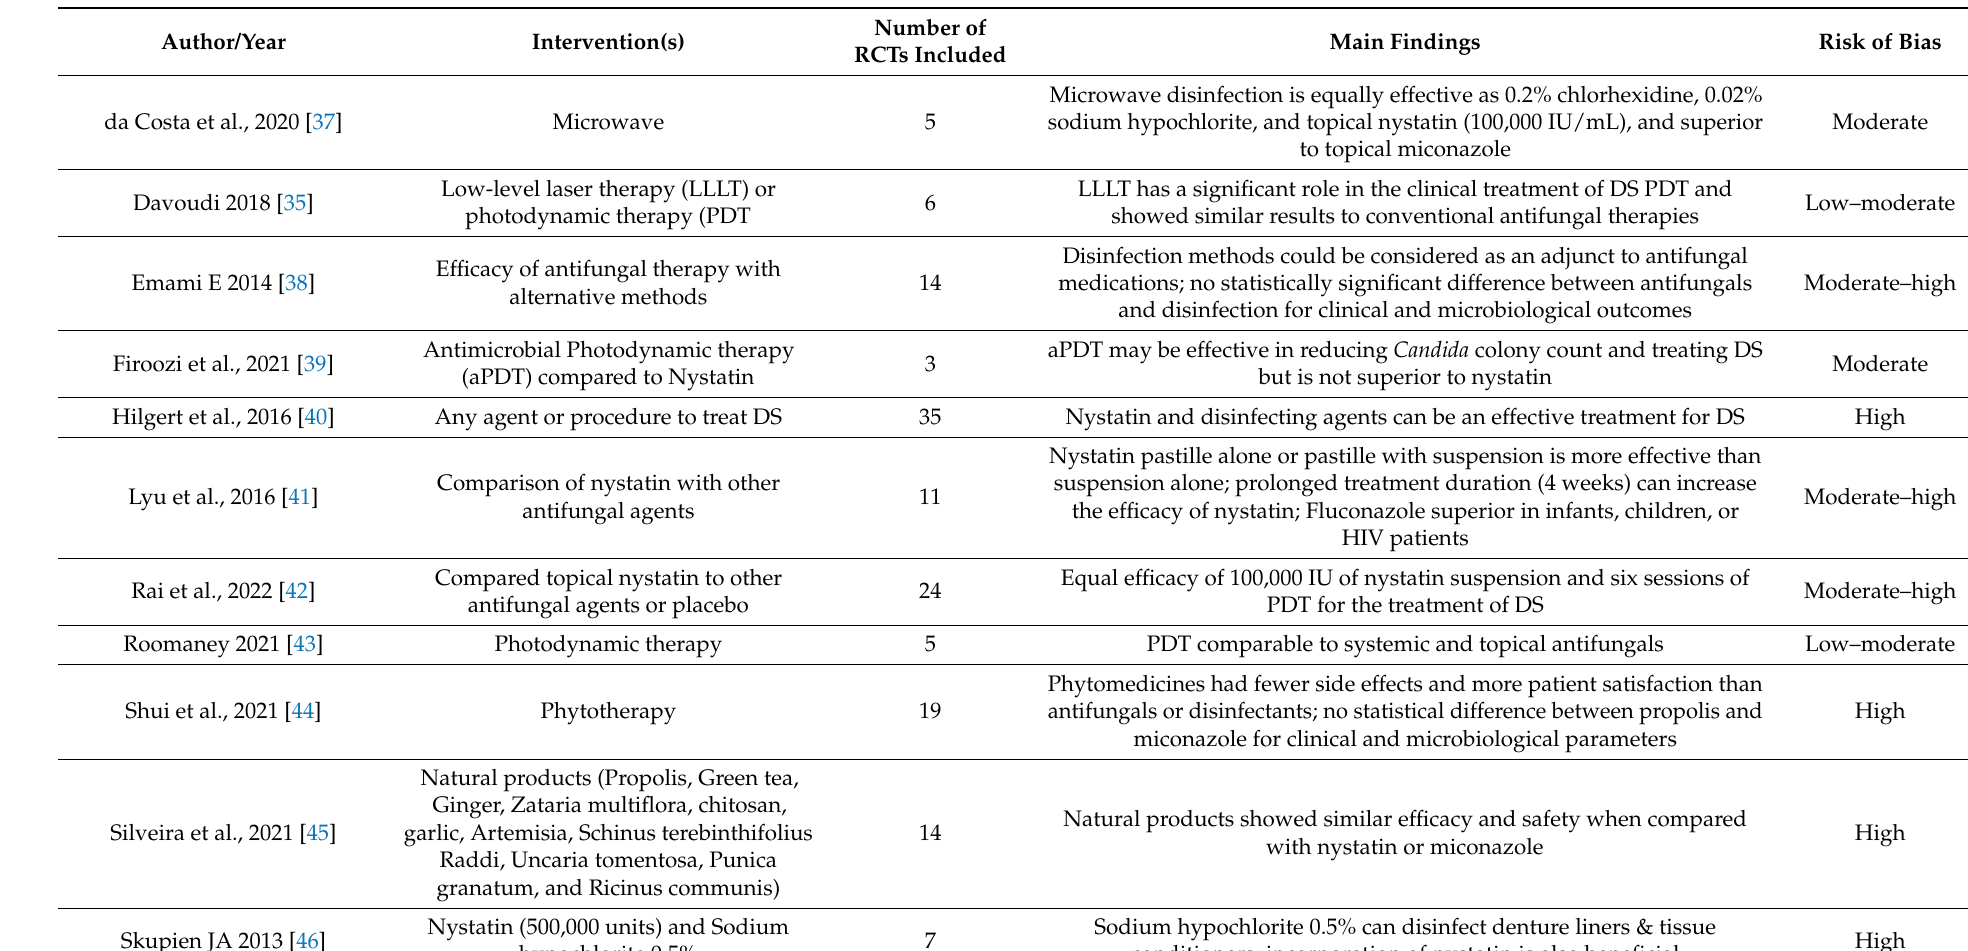
Table 1. Interventions for the Management of Denture